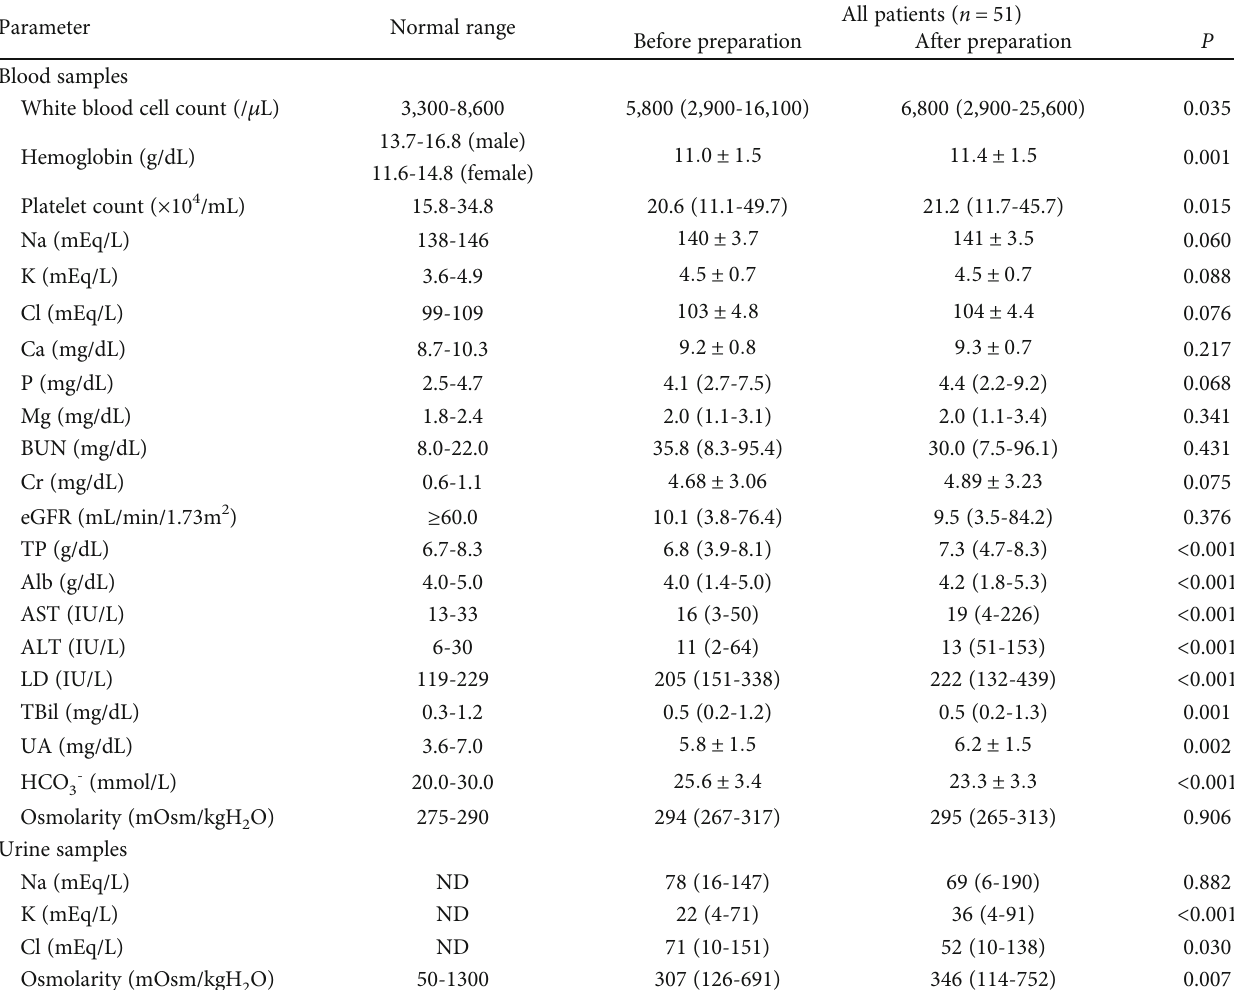
Table 4: Comparison of blood and urine parameters before and after bowel preparation with polyethylene glycol solution plus ascorbic acid in all